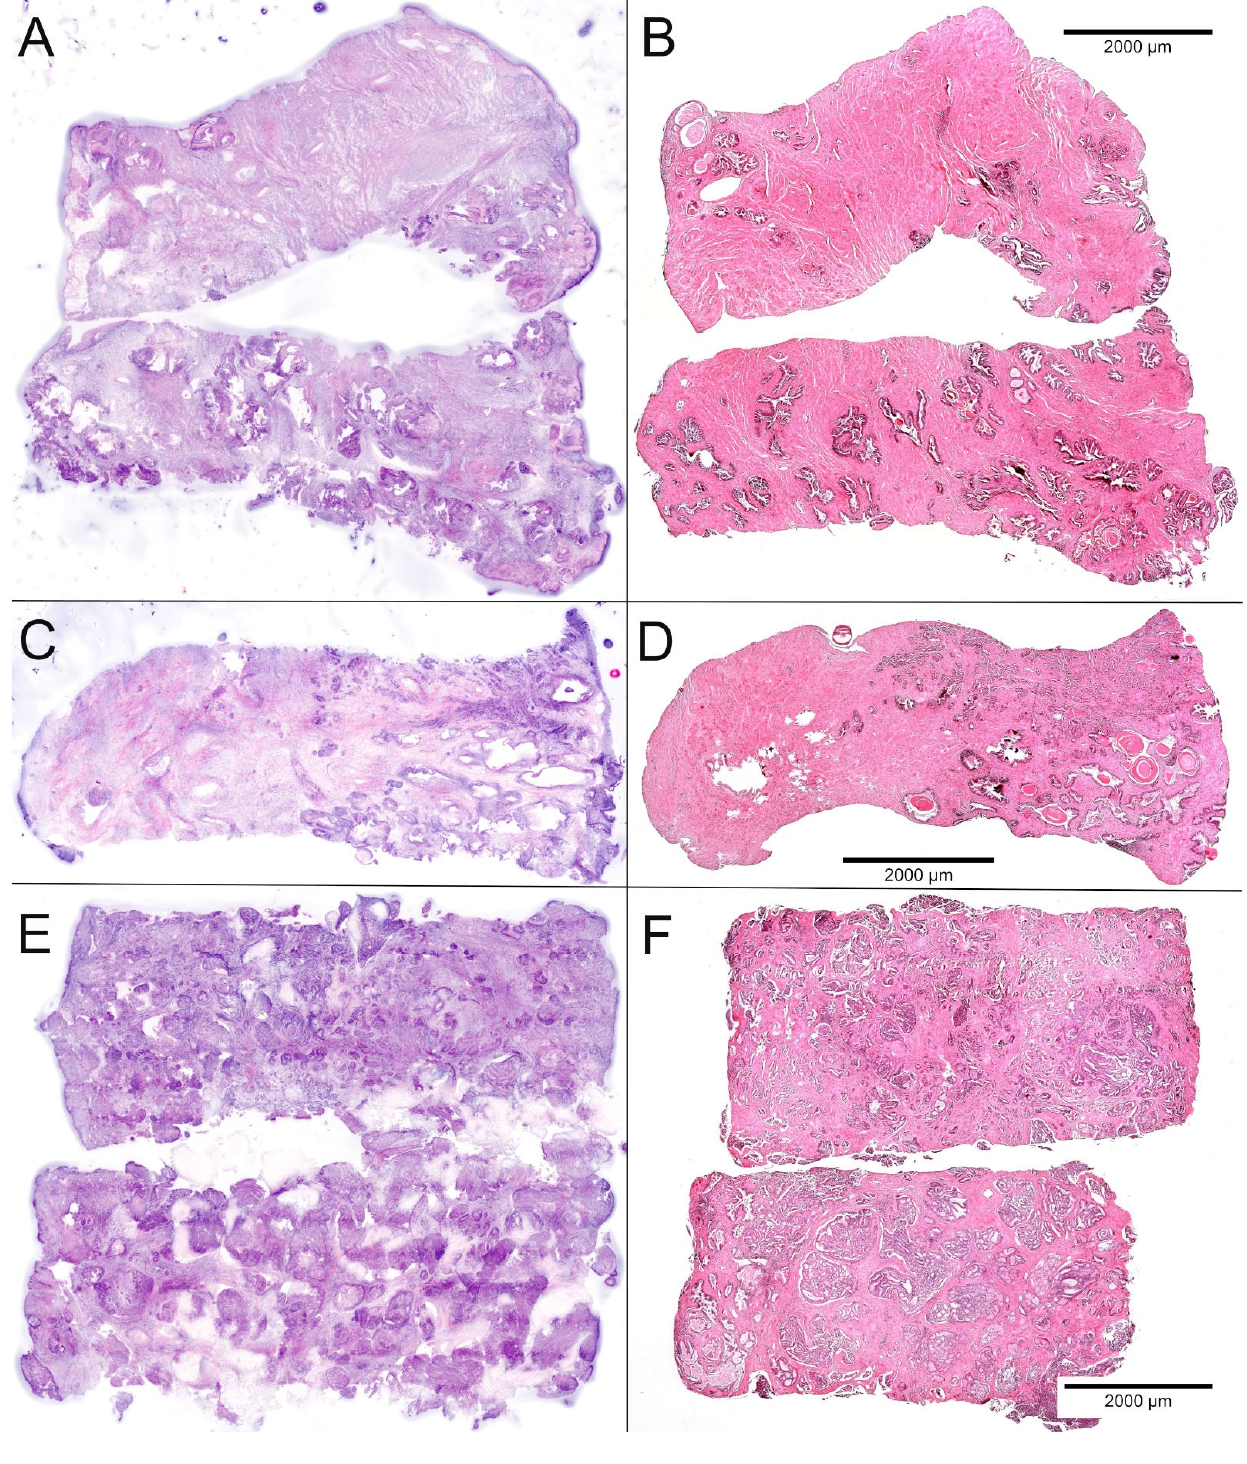
Figure 2. Comparison of FCM scans ( left ) and FFPE sections ( right ) of the biobank samples. ( A , B ) Samples of normal tissue showed stromal nodules and regularly shaped glands with luminal corpora amylacea. ( C , D ) Partial hit with grouped infiltrates of ISUP ‐ grade 1 carcinoma in 25% of the sample. ( E , F ) Full hit revealing 90–100% of poorly differentiated carcinoma in two punch biopsies.